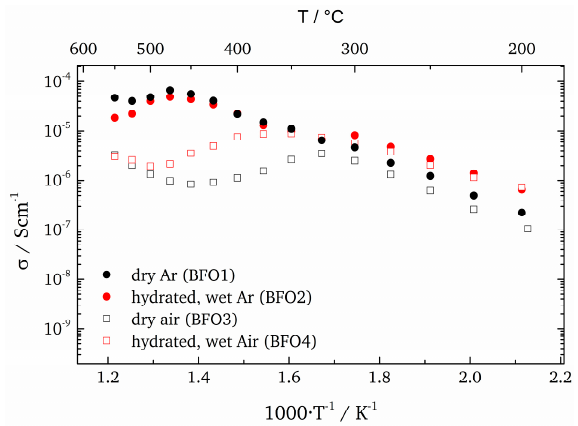
Figure 12. Arrhenius plots (only bulk contribution) under different measurement conditions.